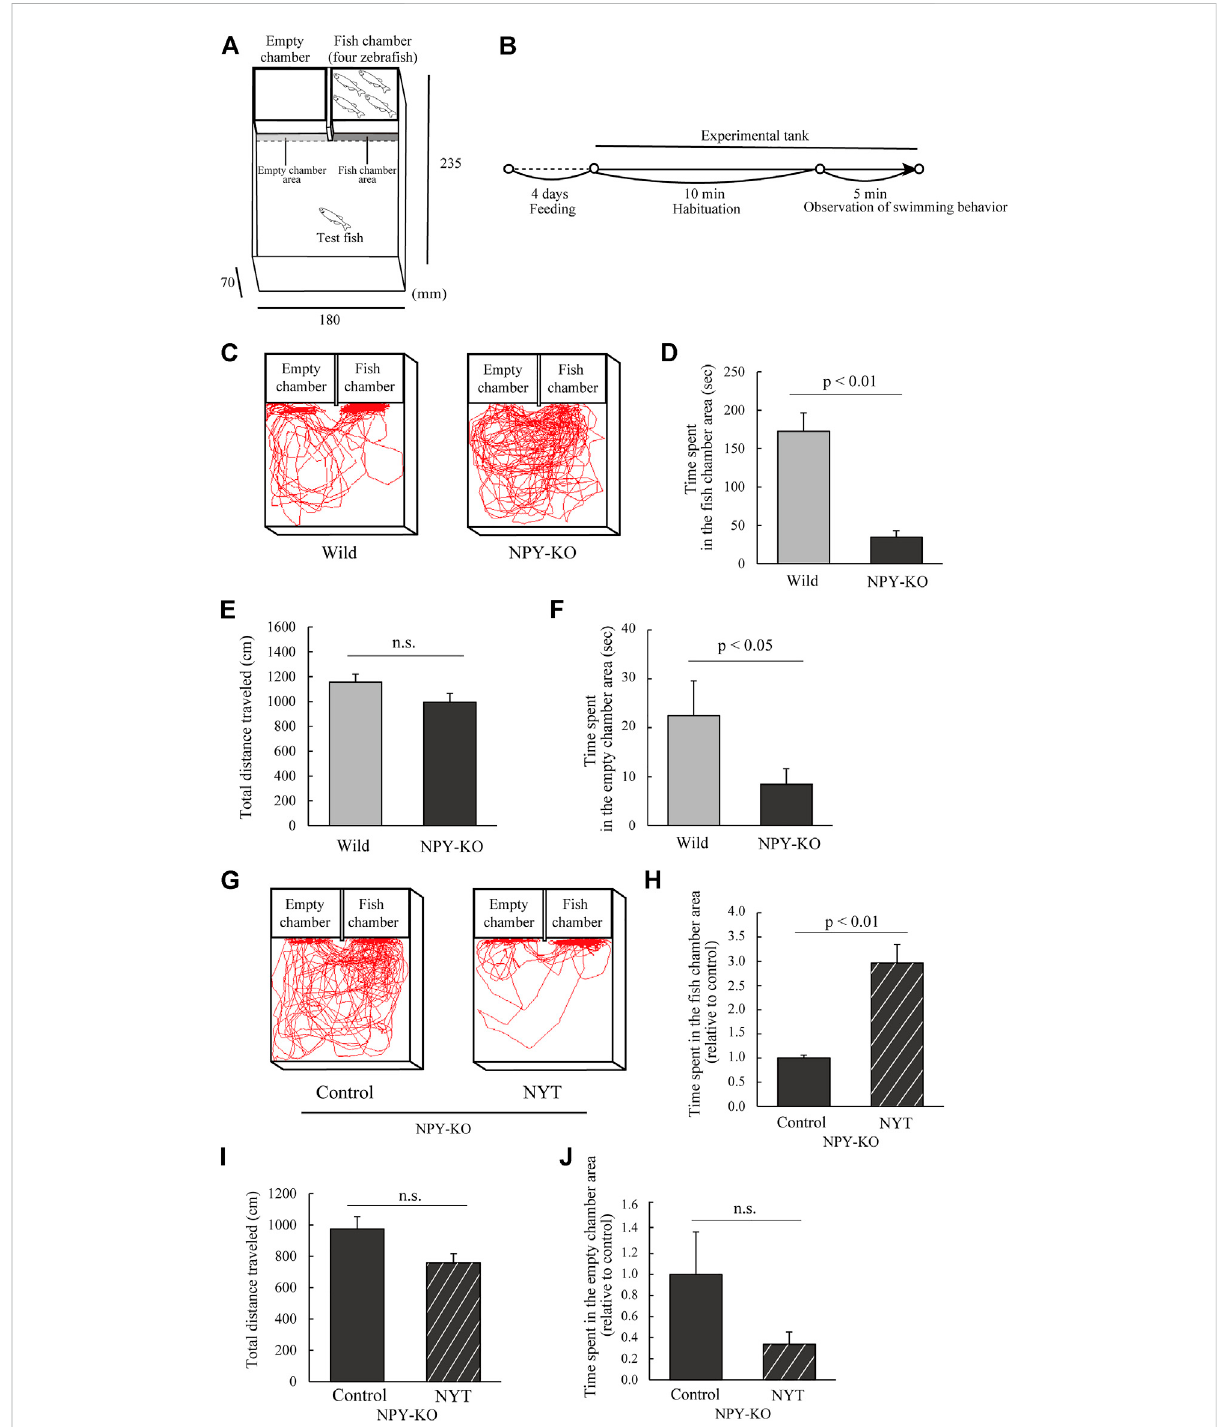
Effect of NYT on sociability in NPY-KO zebra fi sh. Wild and NPY-KO zebra fi sh were fed either control or NYT twice a day for 4 days. Sociability was analyzed using the 3-chambers test. (A) Test apparatus. (B) Experimental scheme for behavioral evaluation. (C) Tracking of wild (left) and NPY- KO zebra fi sh (right) swimming behavior. (D) Time spent in the fi sh chamber area in wild and NPY-KO zebra fi sh. (E) Total distance traveled in the WT and NPY-KO zebra fi sh. (F) Time spent in the empty chamber area of wild and NPY-KO zebra fi sh. Wild, n = 9; NPY-KO, n = 8. (G) Tracking of control(left)andNYT-fed(right)NPY-KOzebra fi shswimming behavior. (H) Timespentinthe fi shchamberareaofthecontrolandNYT-fedNPY-KO zebra fi sh. (I) Total distance traveled by control and NYT-fed NPY-KO zebra fi sh. (J) Time spent in the empty chamber area in control and NYT-fed NPY-KO zebra fi sh. n = 8. Results are shown as mean ± standard error of the mean. n.s., not signi fi